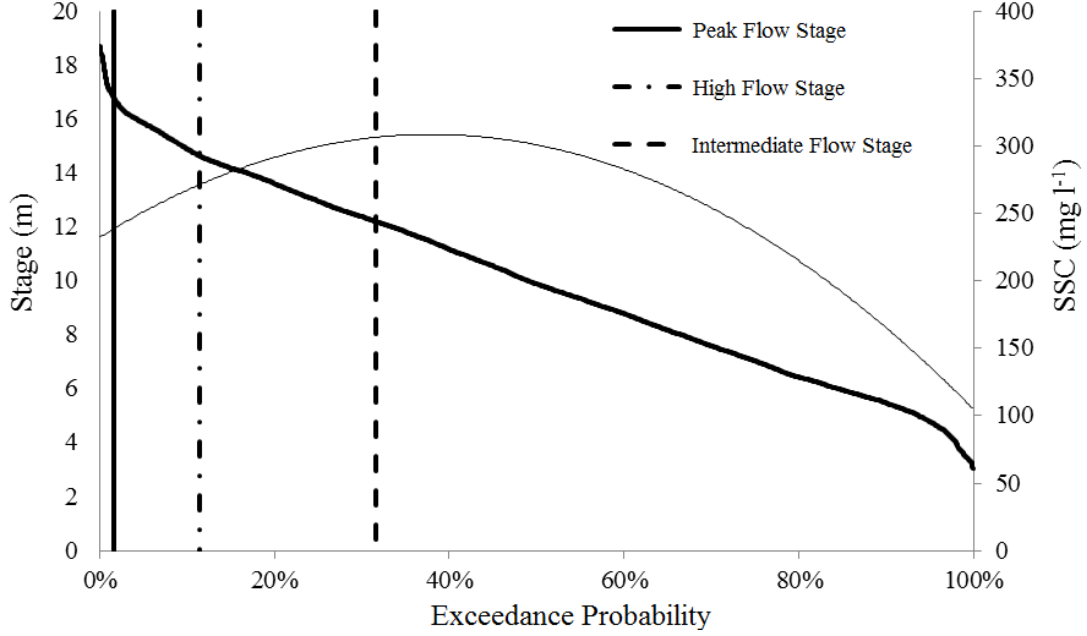
Figure 3. Stage plotted on percent exceedance. Suspended sediment concentration (SSC) is plotted with corresponding stage exceedance value and does not represent SSC exceedance. Line at 32.0% exceedance corresponds to Intermediate Flow Stage, line at 11.0% exceedance to High Flow Stage, and line at 2.0% exceedance to Peak Flow